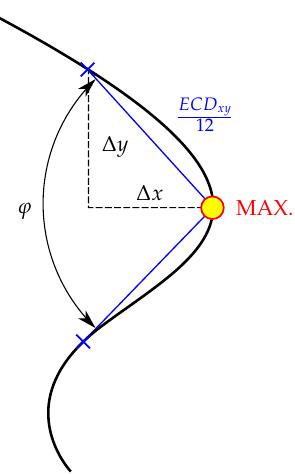
Figure 27. Determination of the effective notch-opening angle.